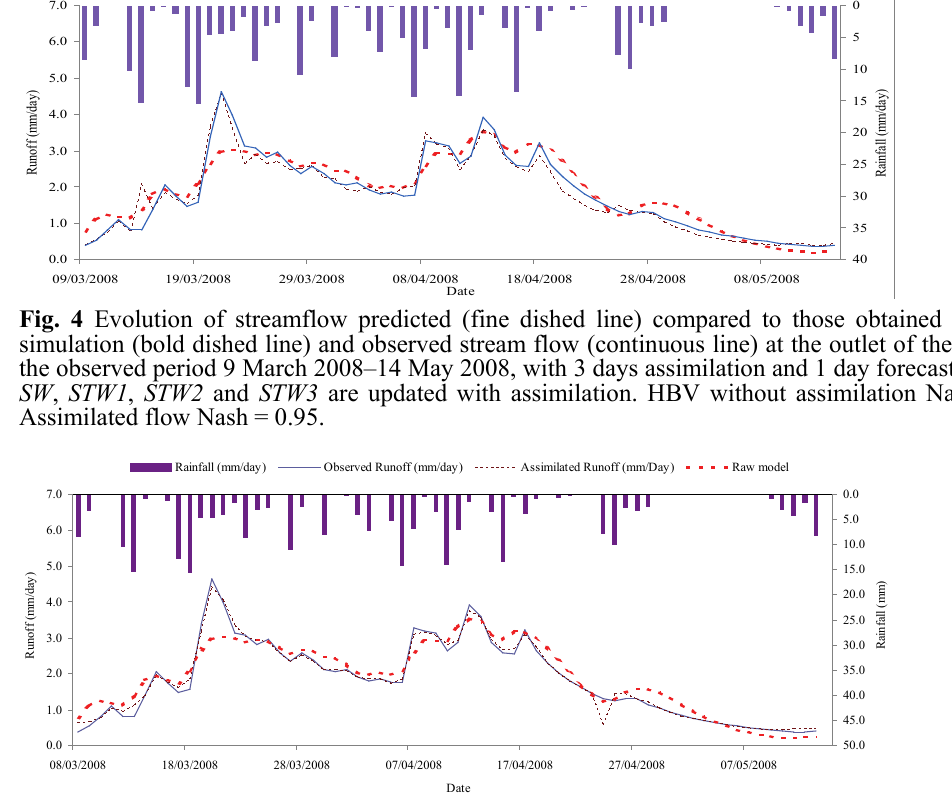
Fig. 5 Evolution of streamflow predicted (fine dished line) compared to those obtained with HBV simulation (bold dished line) and observed streamflow (continuous line) at the outlet of the Serein for the observed period 9 March 2008–14 May 2008, with 2 days assimilation and 1 day forecast lead time. SW , STW1 , STW2 and STW3 are updated with assimilation. HBV without assimilation Nash = 0.87, Assimilated flow Nash =